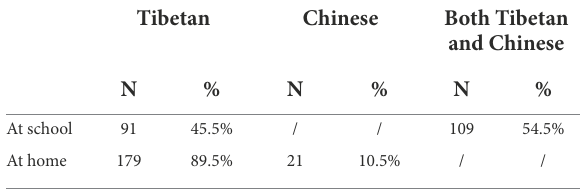
TABLE 3 Tibetan minority students’ language